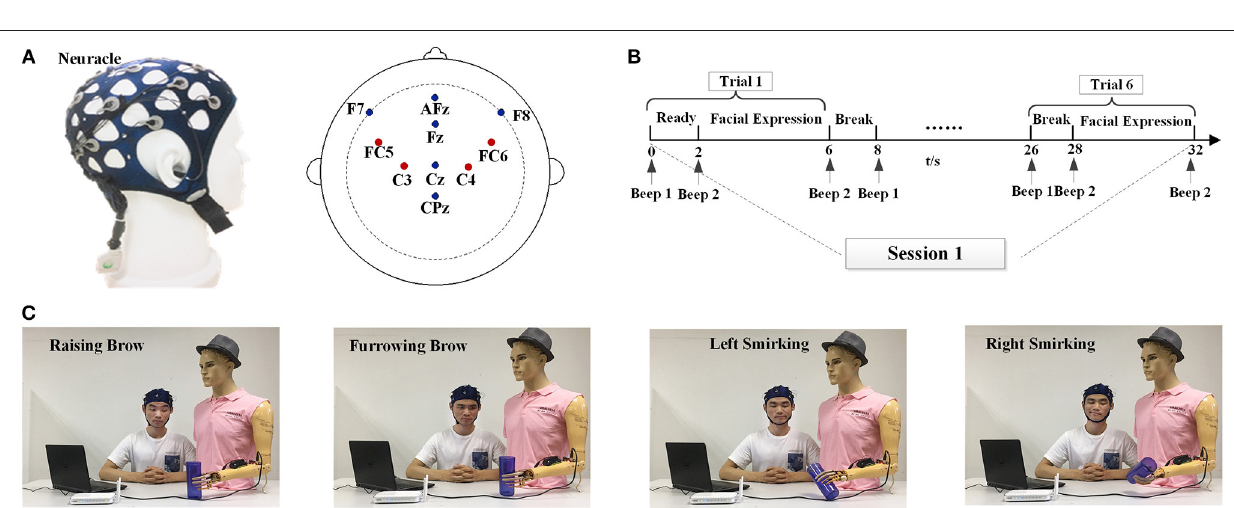
2 sessions. The time series of one session is shown in Figure 2B